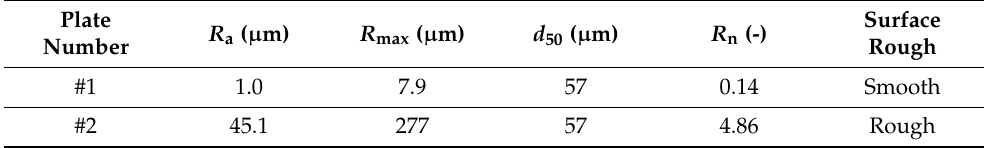
Figure 3. Steel plates for the interface direct shear test: ( a ) smooth and ( b ) rough surfaces. Table 3. Roughness parameters of the steel